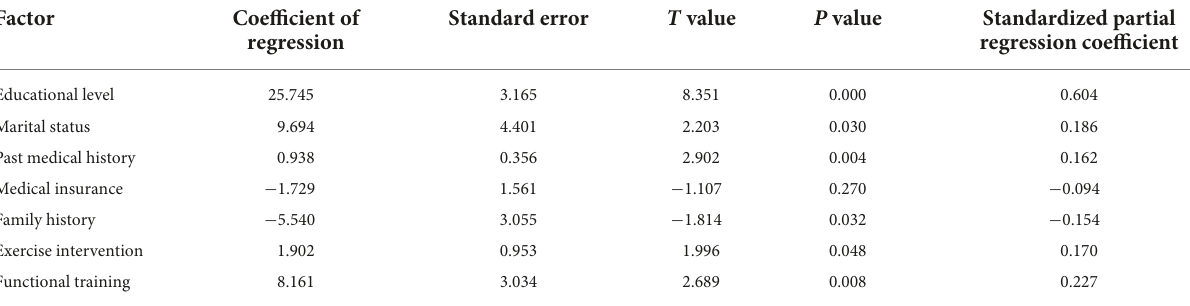
TABLE 5 Results of multiple linear regression analysis of rehabilitation effects in stroke